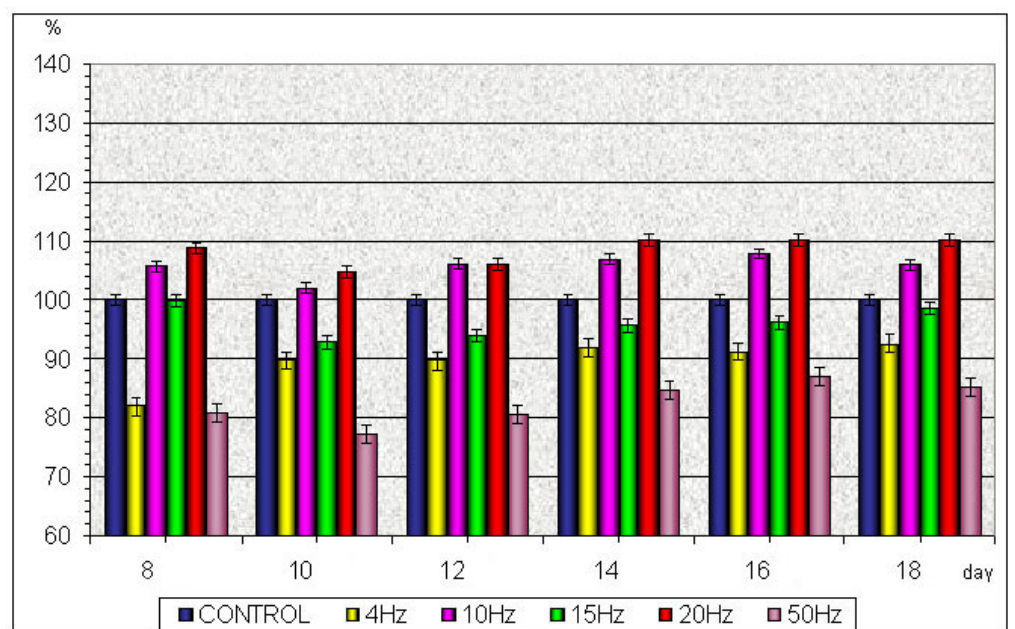
FIGURE 9. The time-dependent process of root formation during 18-days incubation in nontreated (control) and ELFV- pretreated DW. On abscissa, the time (in days) of seed incubation; on ordinates, percent of the changes of root length compared to the control.